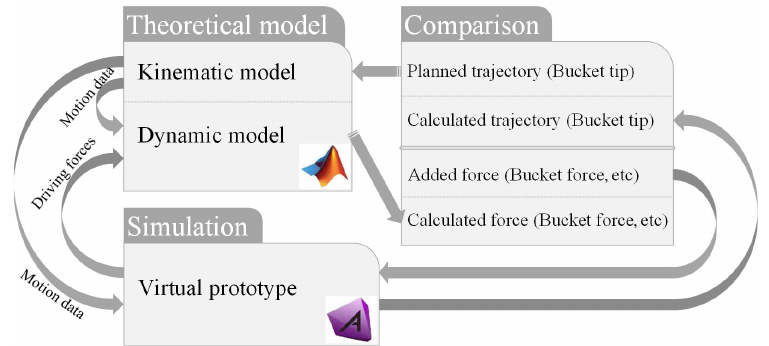
Figure 6. Simulation platform outline.